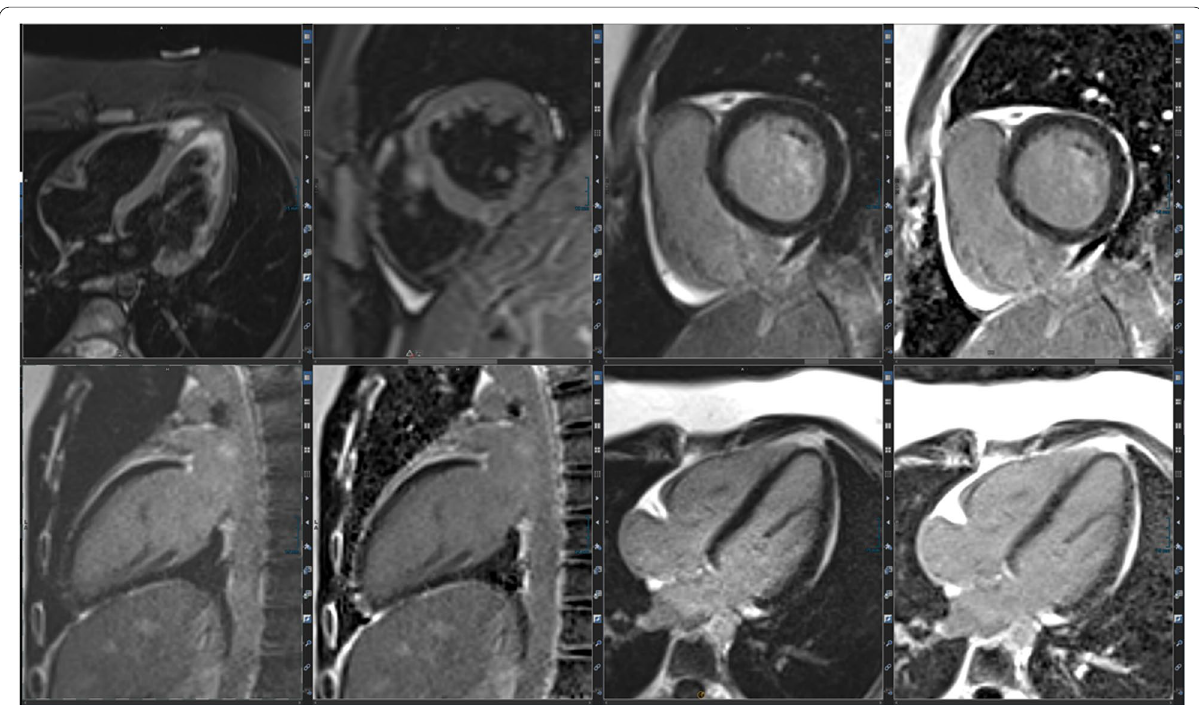
Fig. 6 (Tissue integrity assessment by T2 and LGE imaging): the capability of a non-invasive complete assessment of tissue integrity (edema yes/ no, fibrosis yes/no) is one of the hallmarks of MRI. Healthy myocardium shows a dark (“hypointense”) signal in T2 imaging (first two images in the left upper row) as well as a dark signal in LGE imaging (right upper row LGE-SAX in IR and PS reconstruction; lower row—LV 2CV- and 4 CV-LGE)